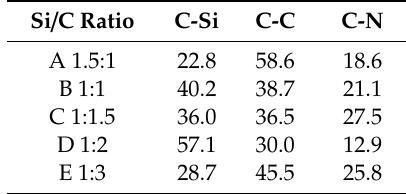
Table 3. The percentage of chemical bonds in C1s (%).